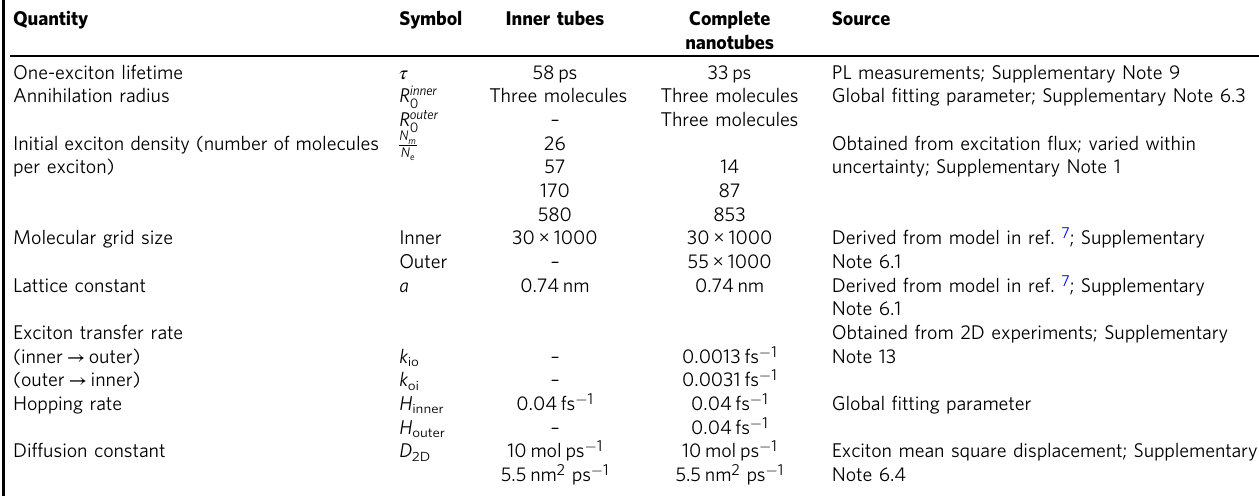
Table 1 Overview of parameters for Monte Carlo simulations of the exciton dynamics for isolated inner tubes and complete